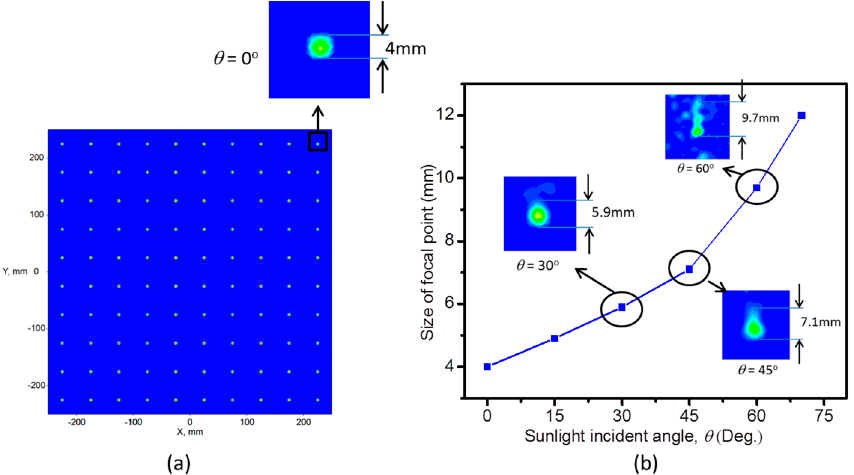
Figure 4. ( a ) Distribution of concentrated sunlight on the focal plane of mirror-coated lens array; ( b ) the dependence of focal area on the sunlight incident angle.